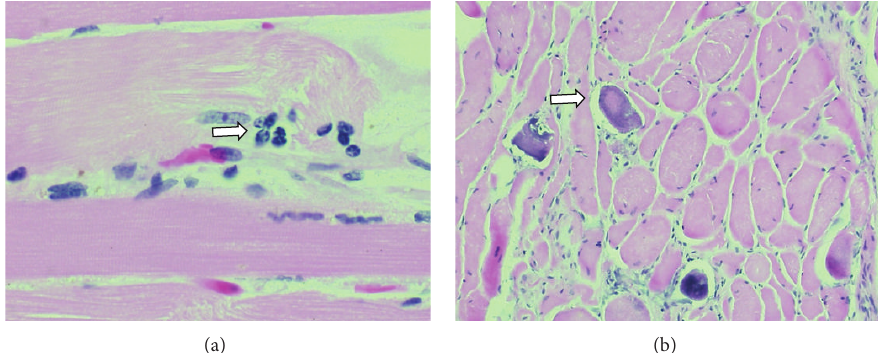
Figure 5: (a) Autopsy of the psoas muscle. Skeletal muscles: nonuniform degree of interior scattered segments of necrotic myofibers in the psoas fascicles without perifascicular myofiber atrophy or necrosis. Extensive morular aggregation of myofiber nuclei in the damaged myofibers (see arrow). Minimal perimysial and endomysial fibrosis, suggesting an acute process. Finding may suggest possible sepsis with intravascular coagulation and capillary disruption. (b) Calcium deposition found in myofiber (see arrow).